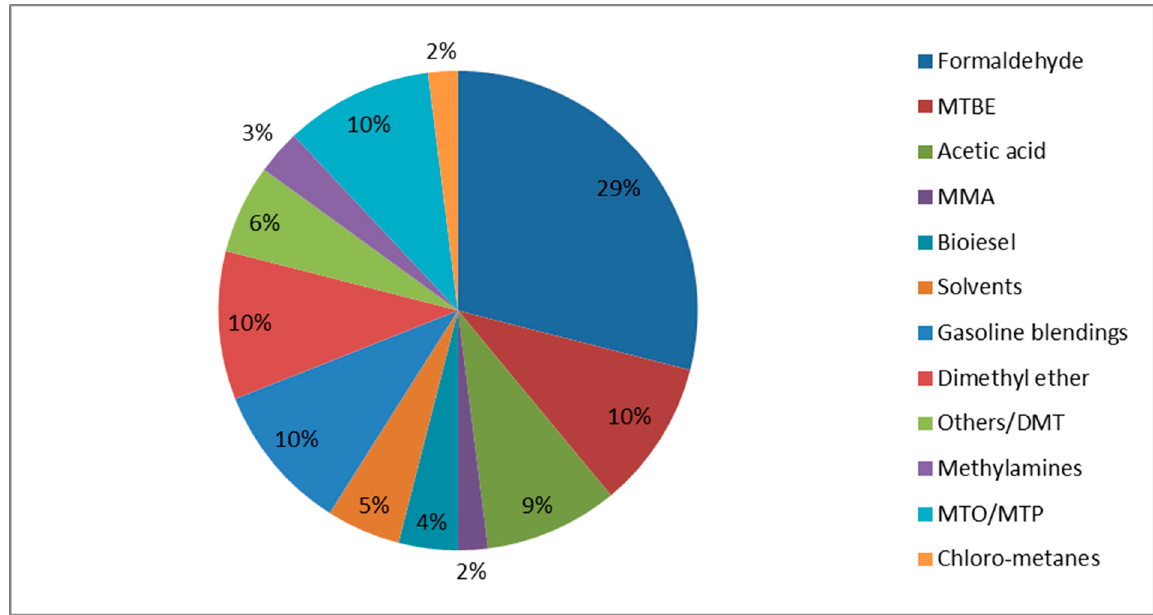
Figure 5. Currently, methanol is the main fuel used.